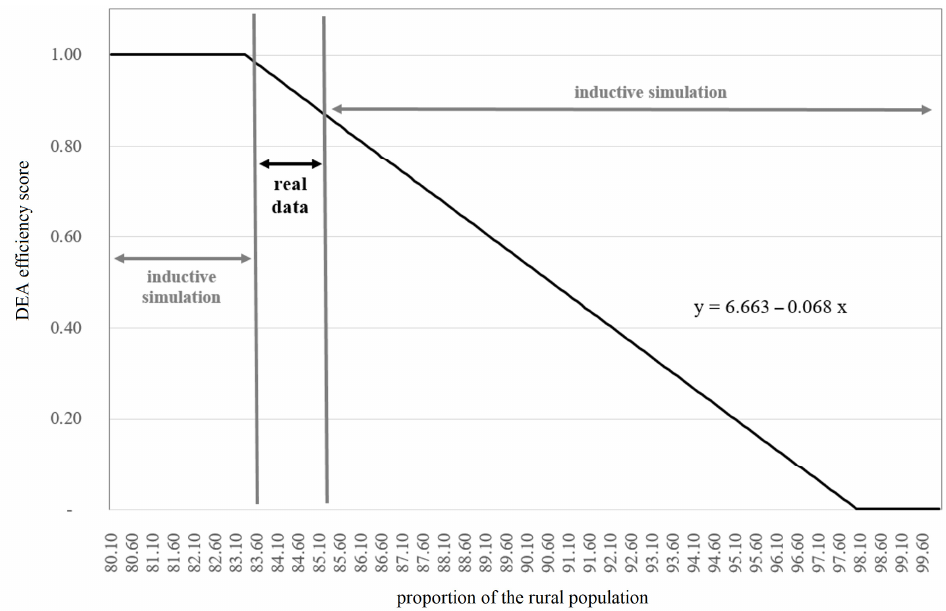
Figure 5. Empirical and simulation data range for a managerial inter-temporal approach.